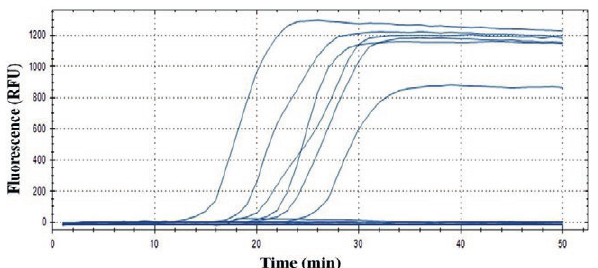
Figure 3. Detection of Pleurostoma richardsiae in inoculated olive plants, using RealAmp assay. Samples used as negative controls showed linear